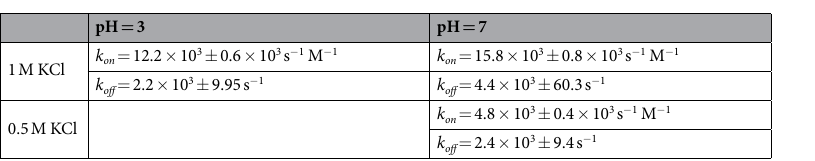
pH = 3 pH = 7 1 M KCl